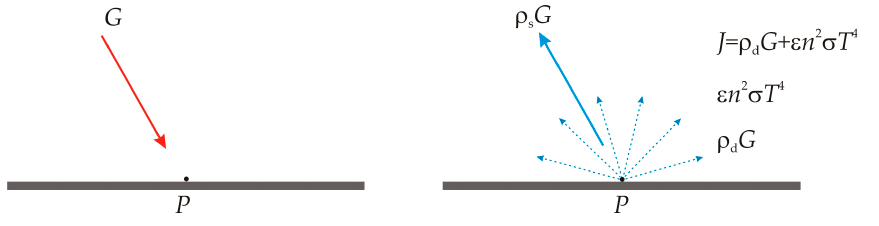
Figure 1. Representation of irradiation G and radiosity J .